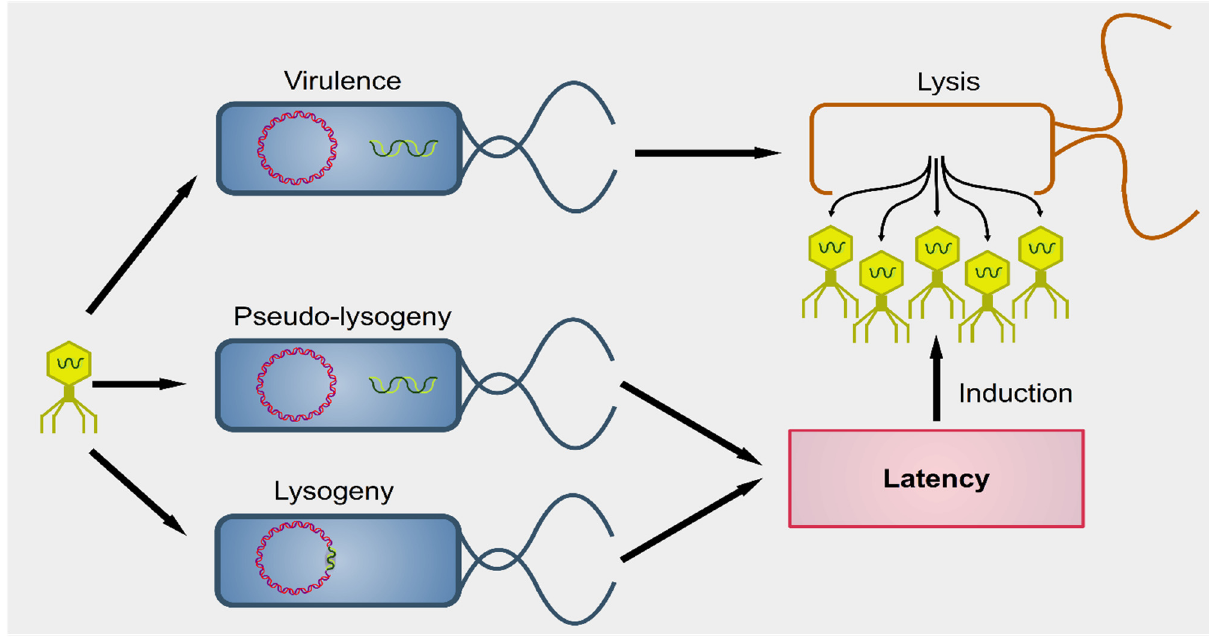
Figure 1. Outcomes of phagial infection of bacteria. A virulent phage (yellow particle on the left) can infect a bacterium (in blue). The replication of the phage leads to lysis of the host cell, releasing the viral progeny (yellow particles on the right). Alternatively, some viral species known as temperate can establish an additional step known as latency. The phagial genome can remain independent from that of the bacterium (pseudo-lysogeny) or become integrated into the host’s genome (lysogeny). In both cases, the viral expression is kept to a minimum and there is no virion production until several cellular conditions are met. Upon induction, temperate phages enter the lytic pathway and determine the lysis of the host.